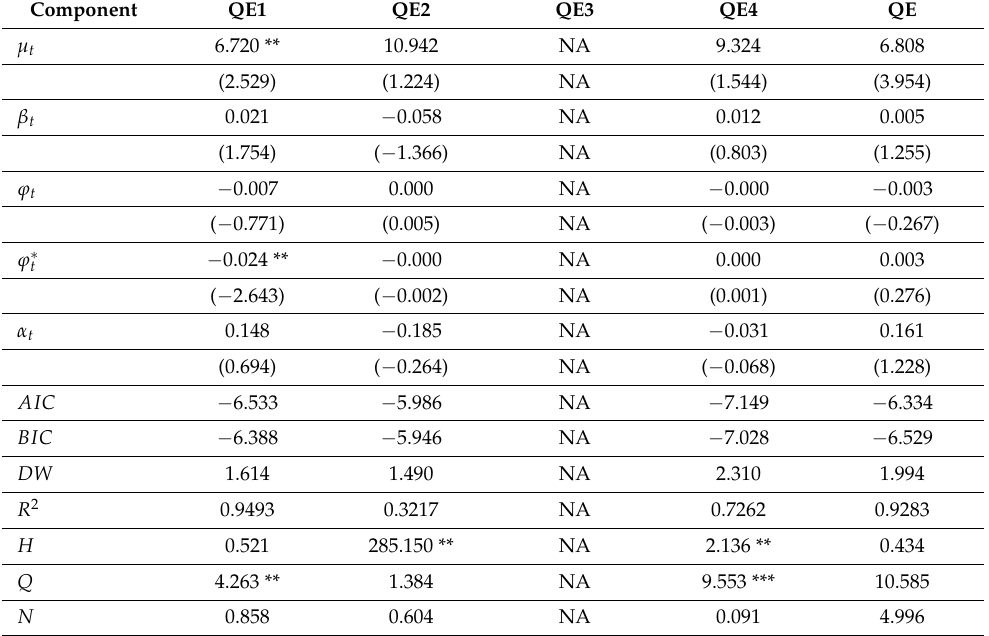
Table 3. Results of Estimating the Model for the Bank of England.